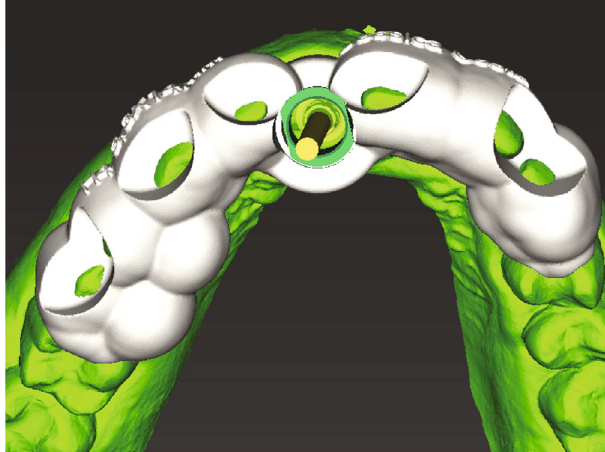
Figure 4: Image of the surgical guide virtually designed using virtual planning software.